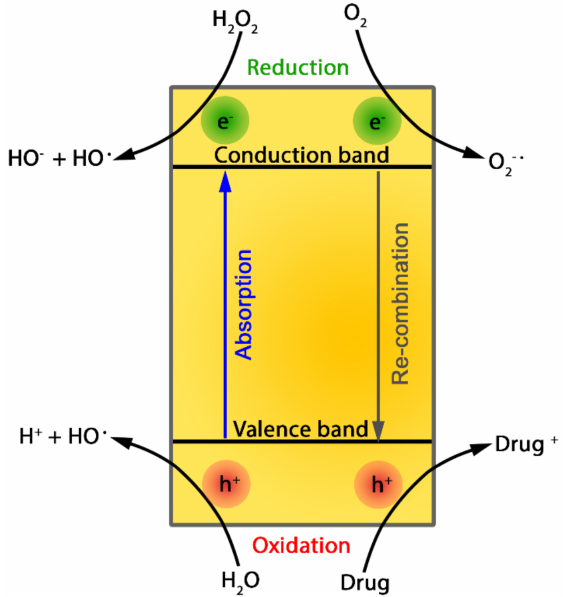
Scheme 2. General mechanism for ROS formation using